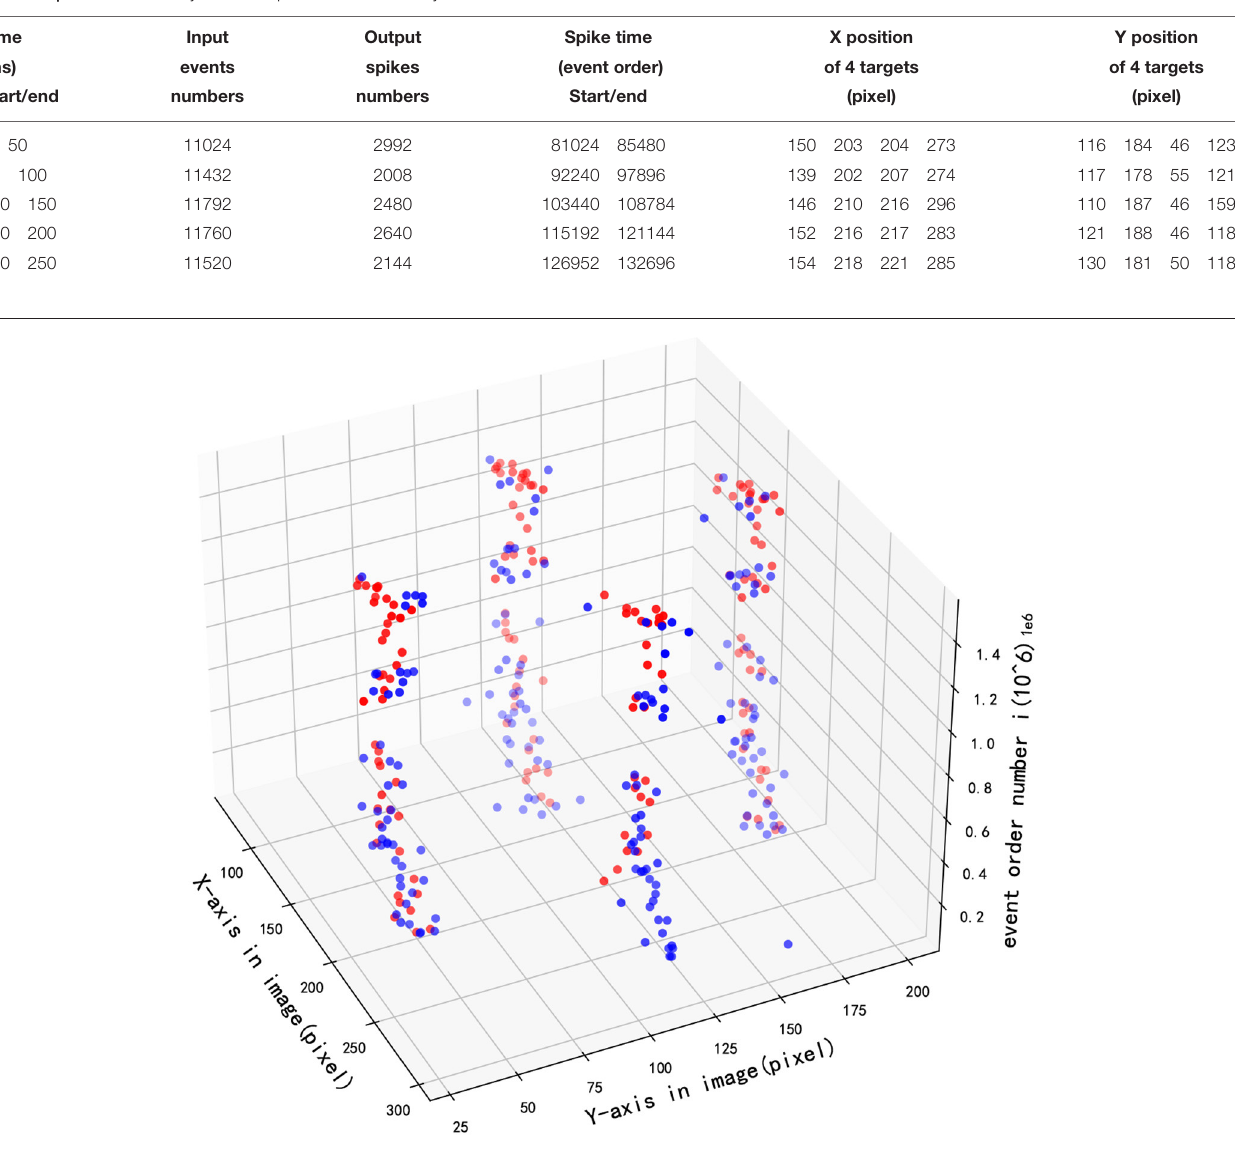
FIGURE 9 | Multi-target tracking effect in